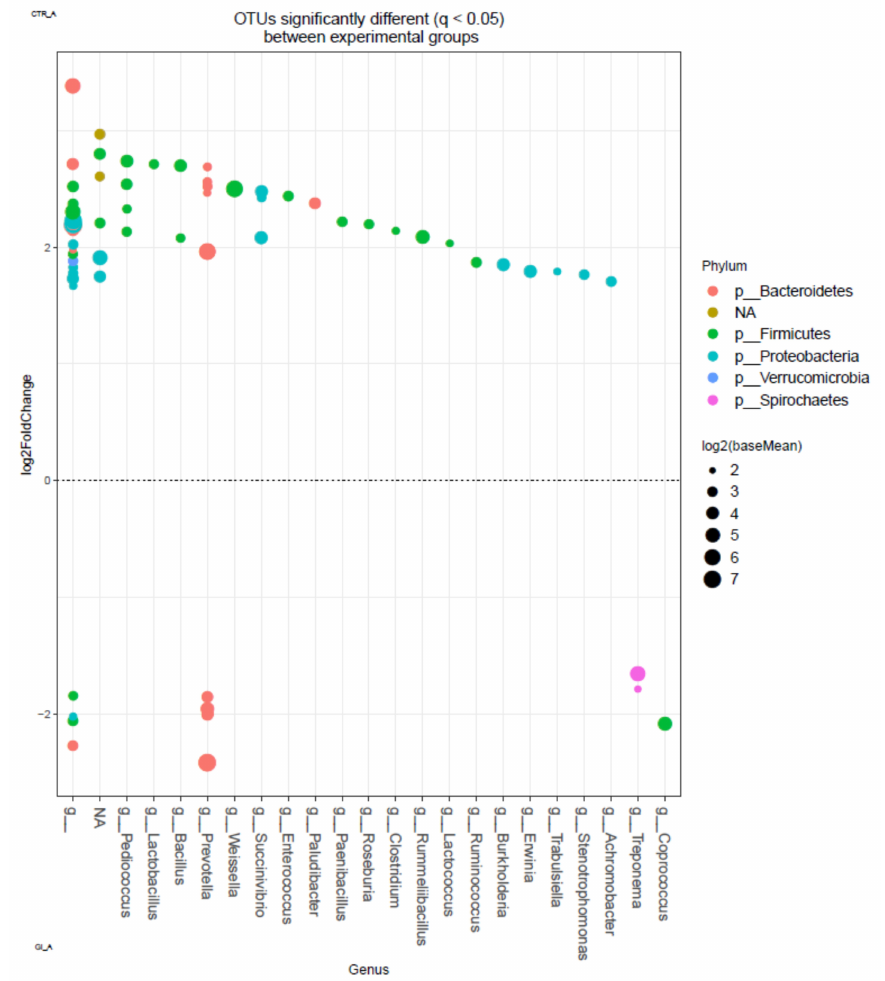
Figure 2. The OTUs at genus level significantly di ff erent (q < 0.05) between rumen samples of cows fed control (above) and cold-pressed sunflower cake (below) in the first period of the experiment (n = 5). Each point represents a single OTU colored by phylum and grouped on the x-axis by taxonomy, size of point reflects the log2 mean abundance of the sequence